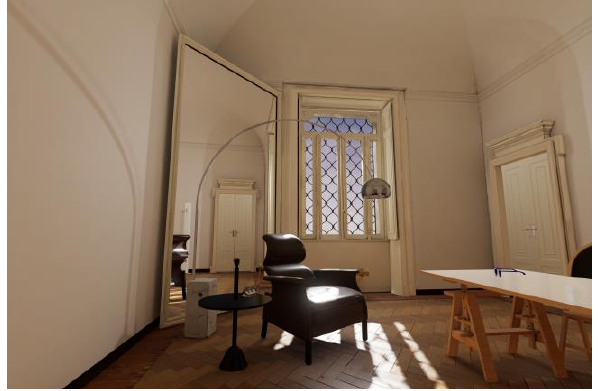
Figure 7. Virtual simulation: view of the Mirror Room.